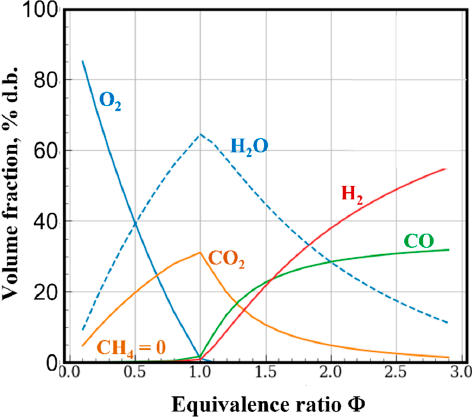
Figure 9. Comparison of measured (symbols) and calculated (curves) volume fractions of cooled dry detonation products of СН 4 / О 2 mixture. The calculation is made for the composition freezing temperature 2200 K.